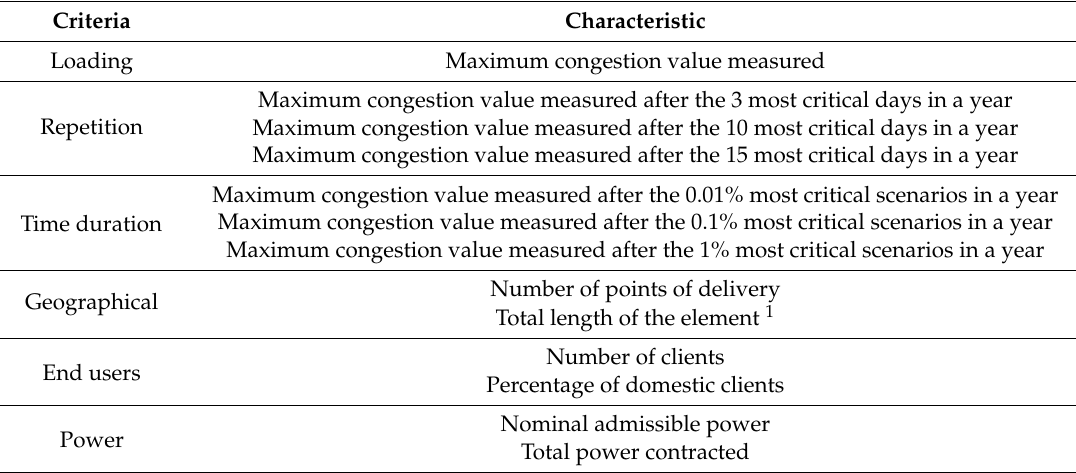
Table 1. Characteristic values of each network element of the